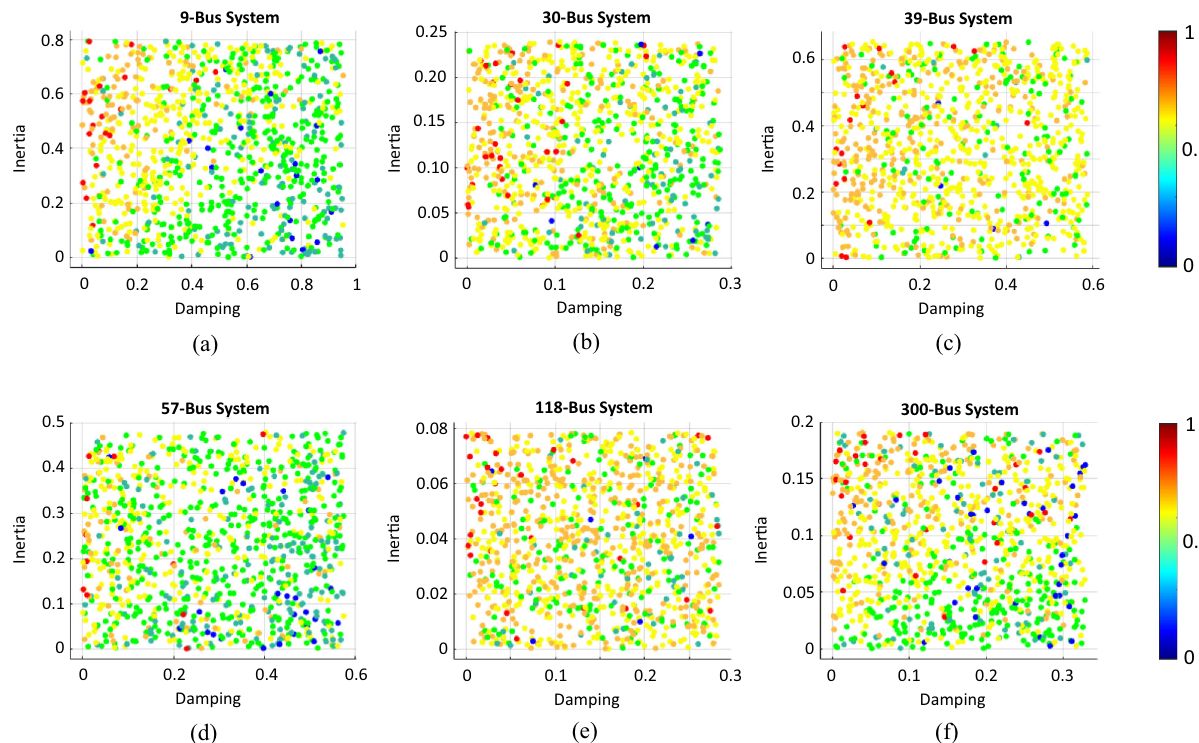
Fig. 5 Normalized values of hertz-sec metric as a proxy for kinetic energy, as a function inertia and damping. a 9-node, 3-generator test network, b 30- node, 6-generator test network, c 39-node, 10-generator test network, d 57-node, 7-generator test network, e 118-node, 54-generator test network, f 300- node, 69-generator test network. The results for 1000 random operating conditions on 6 different power network benchmarks are presented. The observed hertz-sec values are color-coded by the blue dots being the lower values indicating the best network dynamic response, and the red dots being the higher values re fl ecting the worst network dynamic response. The range of other colors should be interpreted accordingly as described by the color guide bar. The x - and y -axes represent the generators damping and inertia, respectively. In all six power networks, the trend of hertz-sec values is such that the improvement of frequency dynamics is evident, proportional to increased damping and reduced inertia (the best dynamic responses appear at the bottom of these plots and more towards right corner whereas the worst dynamic response appear in the top of these plots and more towards left corner). In addition, the impact of damping is more pronounced than that of inertia as the changes in score of hertz-sec are more directly proportional to the changes in damping value than to the changes in inertia value. The description of power networks and the source of their data is provided in Supplementary Note